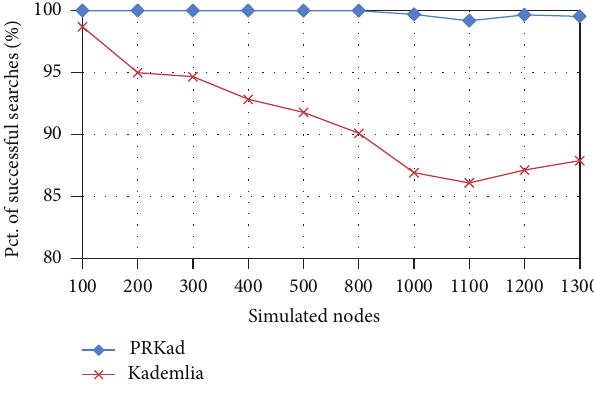
Figure 7: Rate of successful searches.